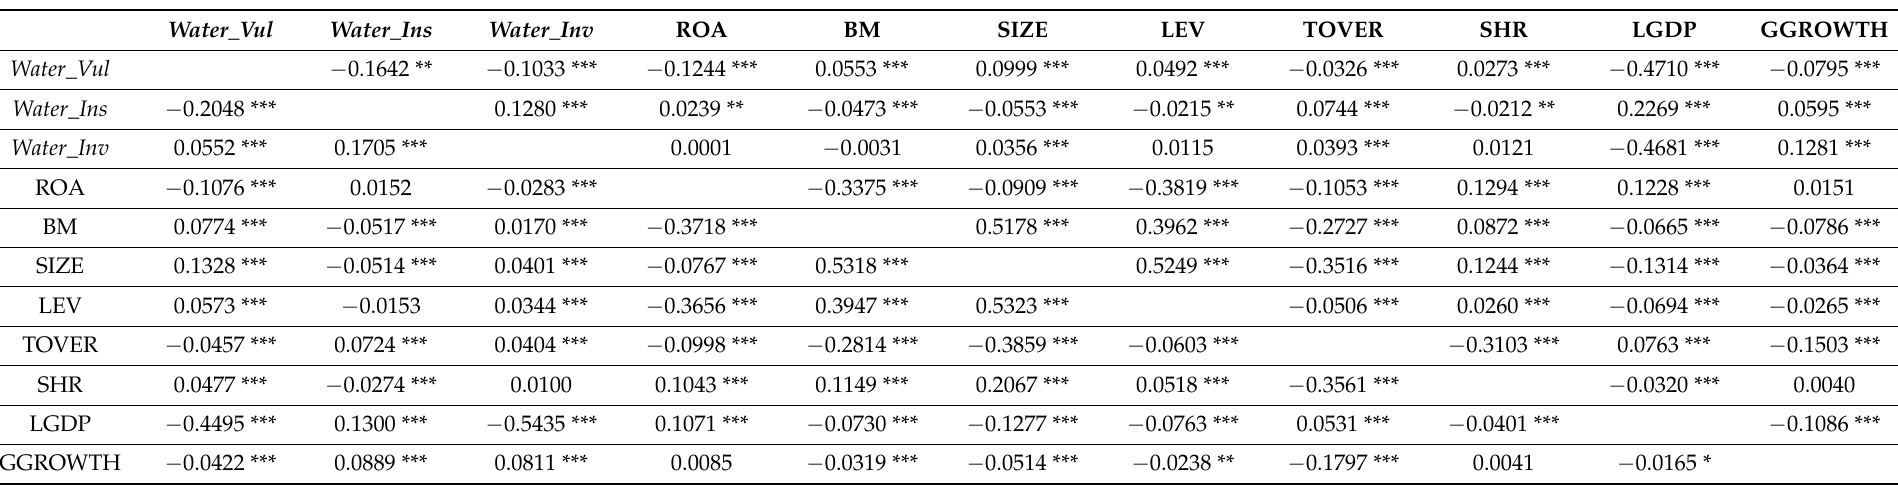
Table 4. Correlation